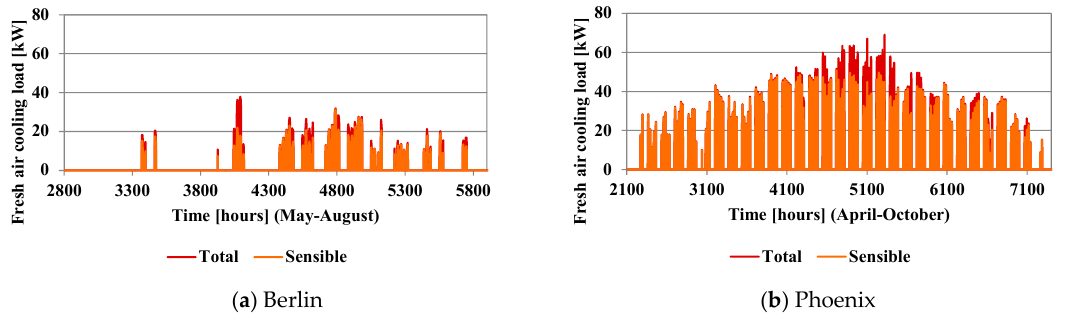
Figure 8. Cooling load variation for two considered locations.